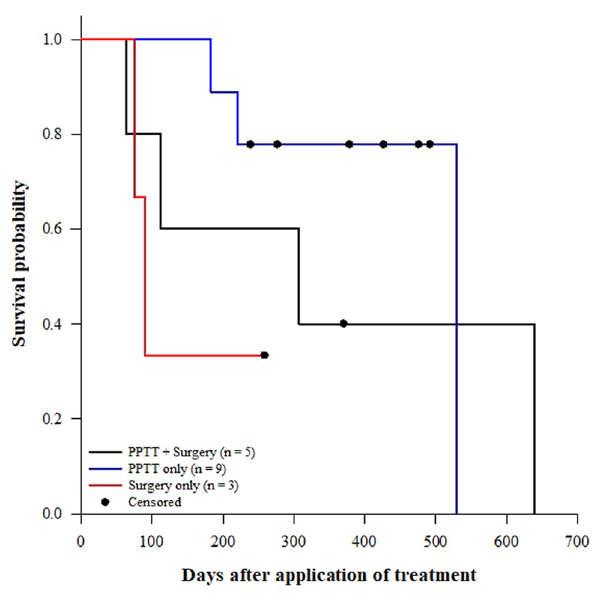
Figure 8. Effect of treatment on survival probabilities of cats with mammary tumors (Log-rank test: χ 2 (2) = 3.13, p = 0.209). Figure was prepared using SigmaPlot v14.0 (Systat Software, San Jose, CA,